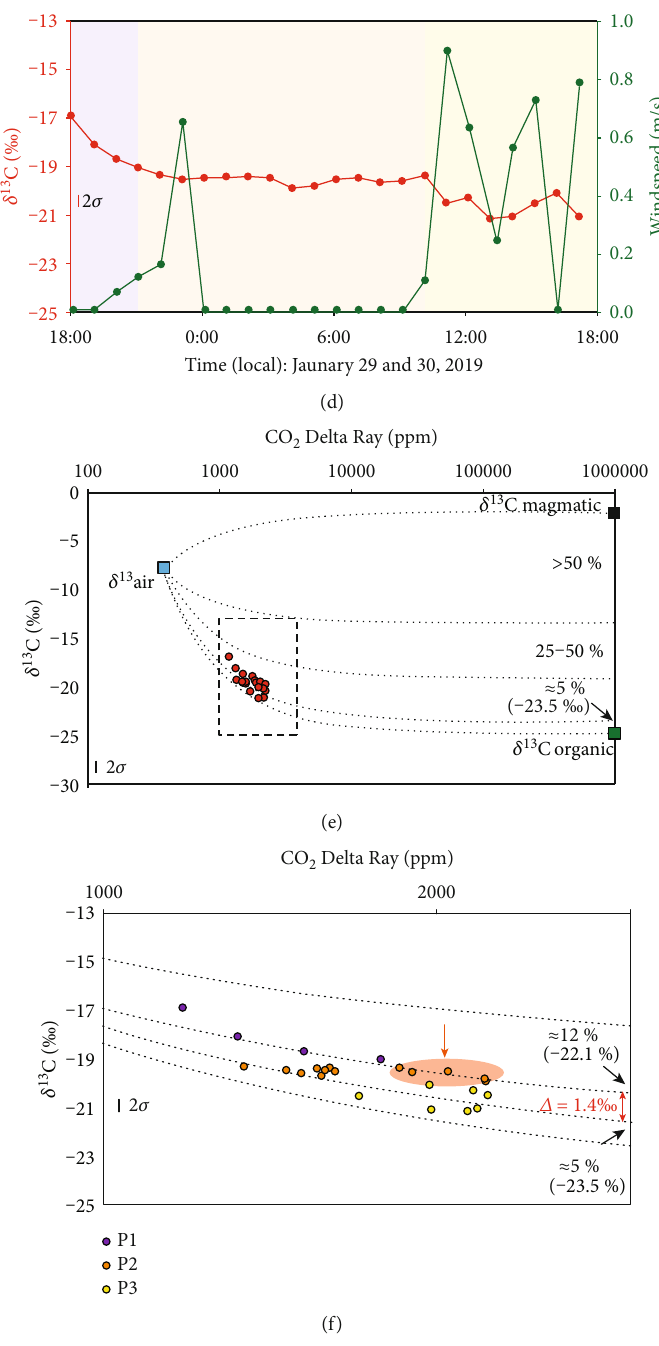
fl ux at Passopisciaro during 24 hours on January 29 and 30, 2019. Figure 9: Time series of semicontinuous δ 13 C measurements from soil CO 2 (a) Comparison between molar CO content in soil measured with the Delta Ray IRIS (black) and from the permanent station of the EtnaGas 2 network less than 20m far. (b) Comparison between molar CO content in soil (black) and related δ 13 C values (red) measured with the Delta 2 (red) measured with the Delta Ray IRIS and (c) the air temperature (blue) and (d) Ray IRIS. Comparison between δ 13 C values from soil CO 2 the windspeed (green) from the Passopisciaro permanent station. (e) Plot of δ 13 C versus CO concentration obtained from soil CO using the 2 2 Delta Ray IRIS. Magmatic end-member ( δ 13 C = − 2 : 2 ‰ ; CO = 1000000ppm ) for Mount Etna, air values ( δ 13 C = − 8 : 0 ‰ ; CO = 380ppm ), 2 2 and biogenic end-member ( δ 13 C = − 24 : 7 ‰ ; CO = 1000000 ppm ) from [17, 24]. (f) Zoom of the plot of δ 13 C versus CO concentration. P1 2 2 (purple) for the period marked by air mixing in the probe. P2 (orange) for the night period. P3 (yellow) for the day period. “ Anomalous ” δ 13 C values during the P2 period diverging from the main air-biogenic mixing line highlighted with orange